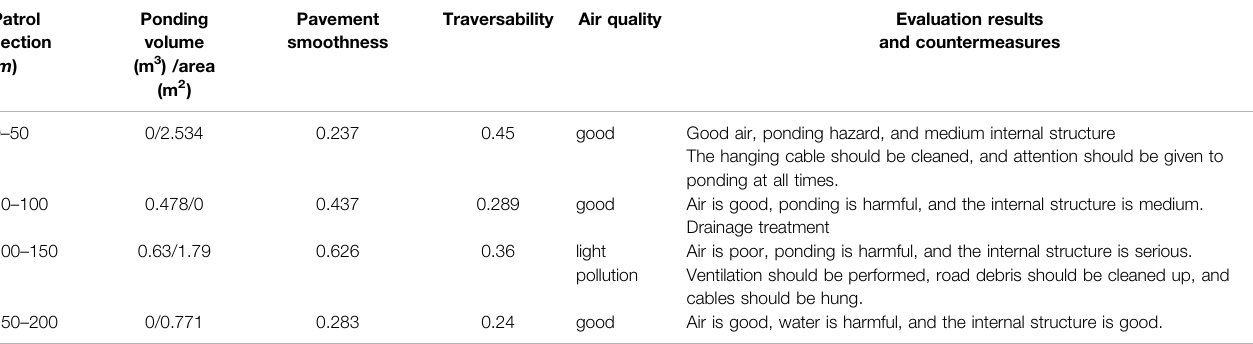
TABLE 3 | Assessment results and